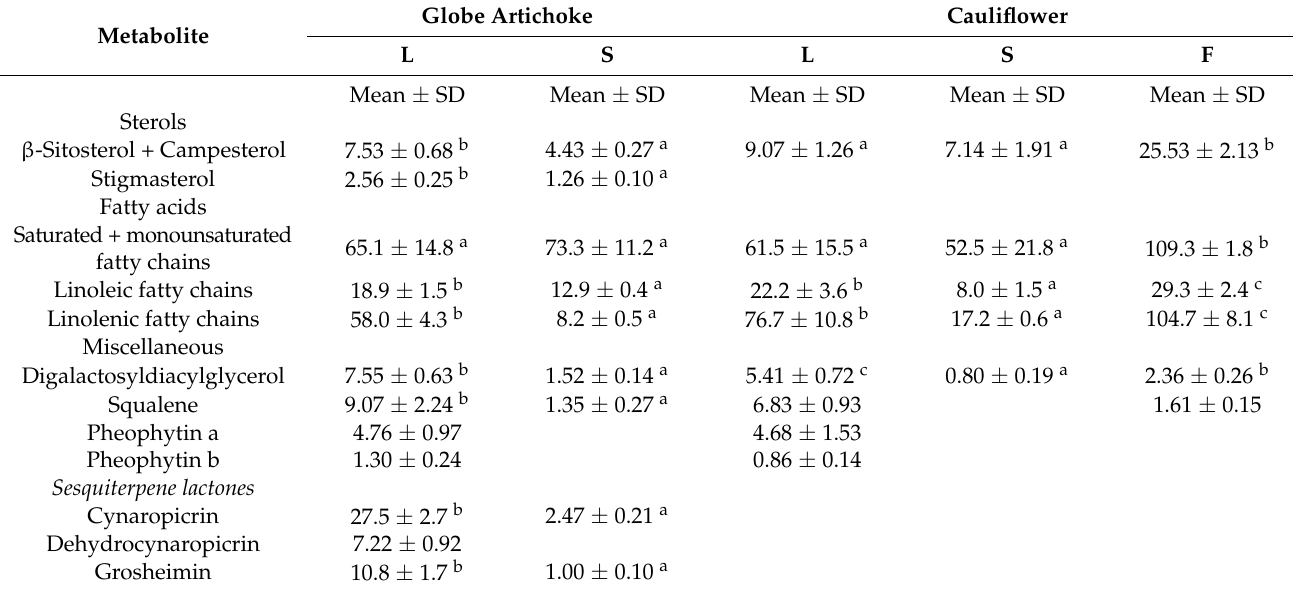
Table 5. Metabolite content (in µ mol/g DW) in organic extracts of cauliflower and globe artichoke byproducts. Sesquiterpene lactones content is reported in mg/g